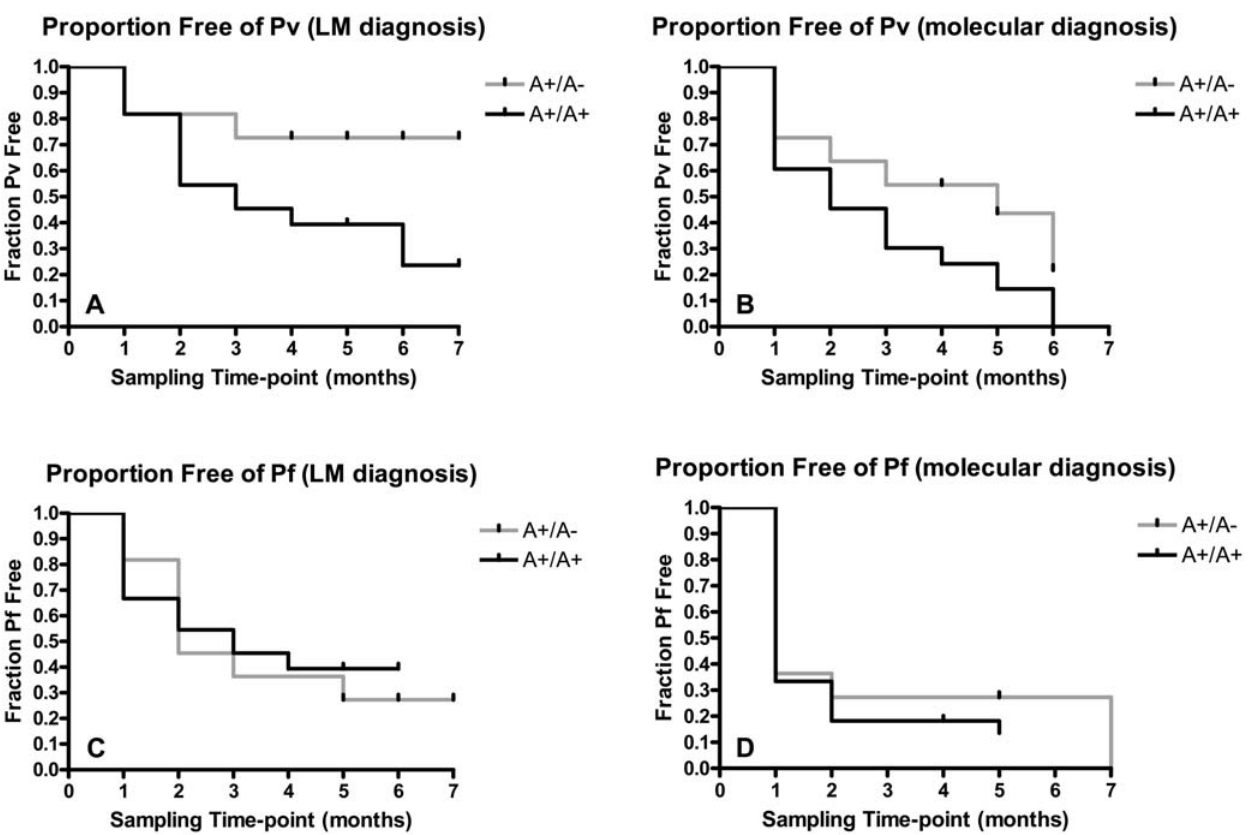
Figure 2. Susceptibility to blood-stage infection during monthly prevalence surveys (1998–99); matched longitudinal analyses. Evaluation of cumulative Pv and Pf erythrocyte infection was performed among Duffy A + /A 2 vs A + /A + individuals matched by age, sex, and village of residence. A, Diagnosis of Pv erythrocyte infection was performed by light microscopy (LM) ( p =0.049; log-rank test) [16]. B, Diagnosis of Pv erythrocyte infection was performed by LDR-FMA ( p =0.065; log-rank test) [20]. C, Diagnosis of Pf erythrocyte infection was performed by LM ( p =0.675; log-rank test). D, Diagnosis of Pf erythrocyte infection was performed by LDR-FMA ( p =0.453; log-rank test). In A through D, light gray lines represent A + /A 2 (n=11) and dark gray lines represent A + /A + (n=33). Whitney U : p = 0.023) (Figure 3A) This difference in the mean Pv